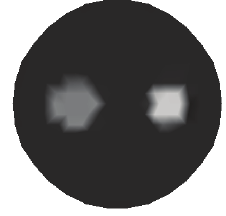
Figure 1: Model of reconstruction.